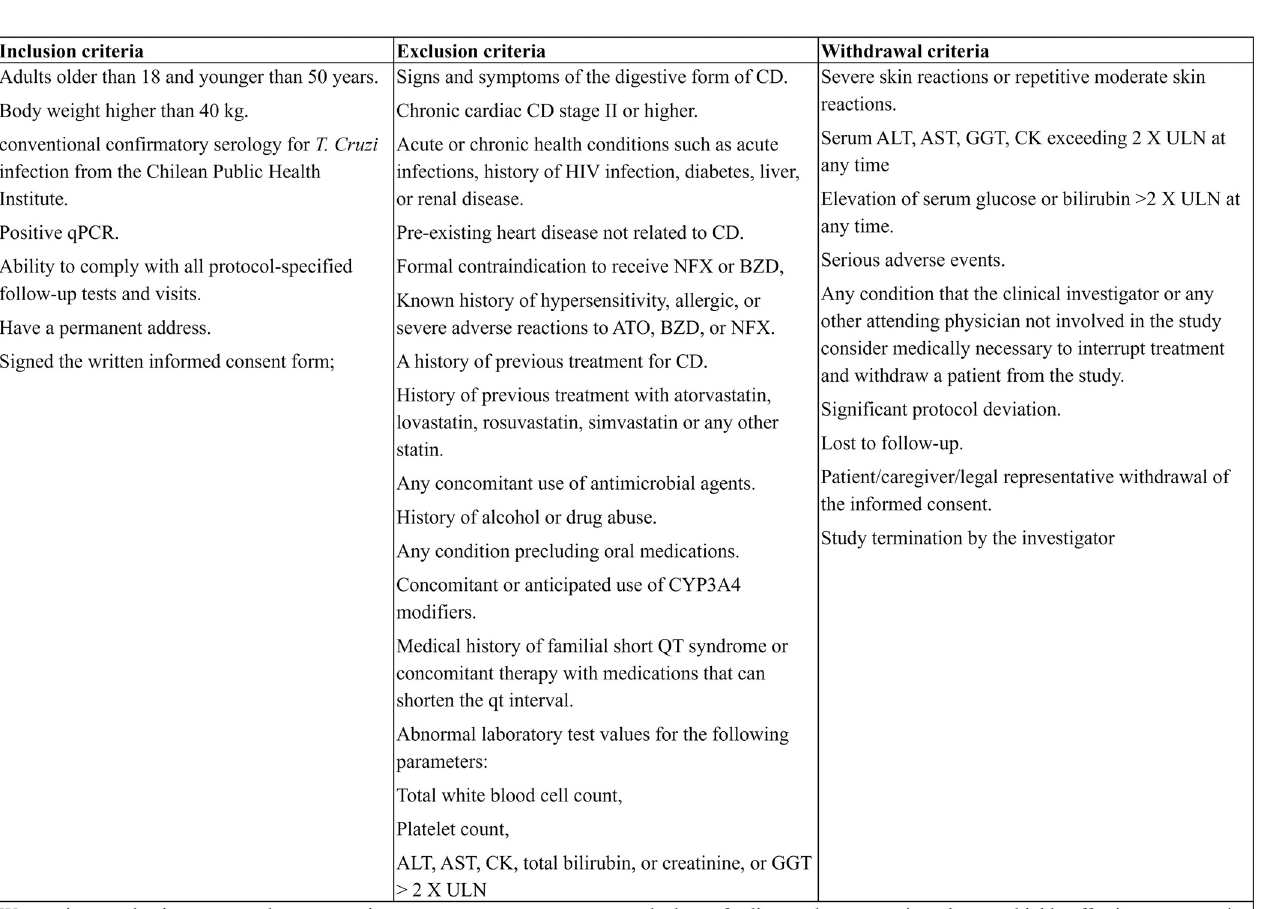
Fig 3. Criteria for inclusion, exclusion, and withdrawal of study